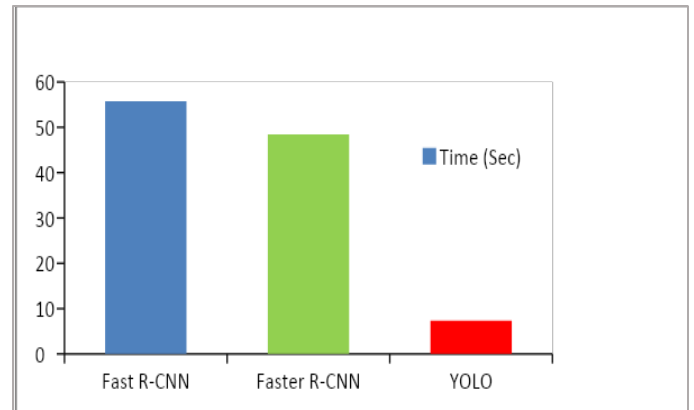
Figure 14. Time is taken to detect.